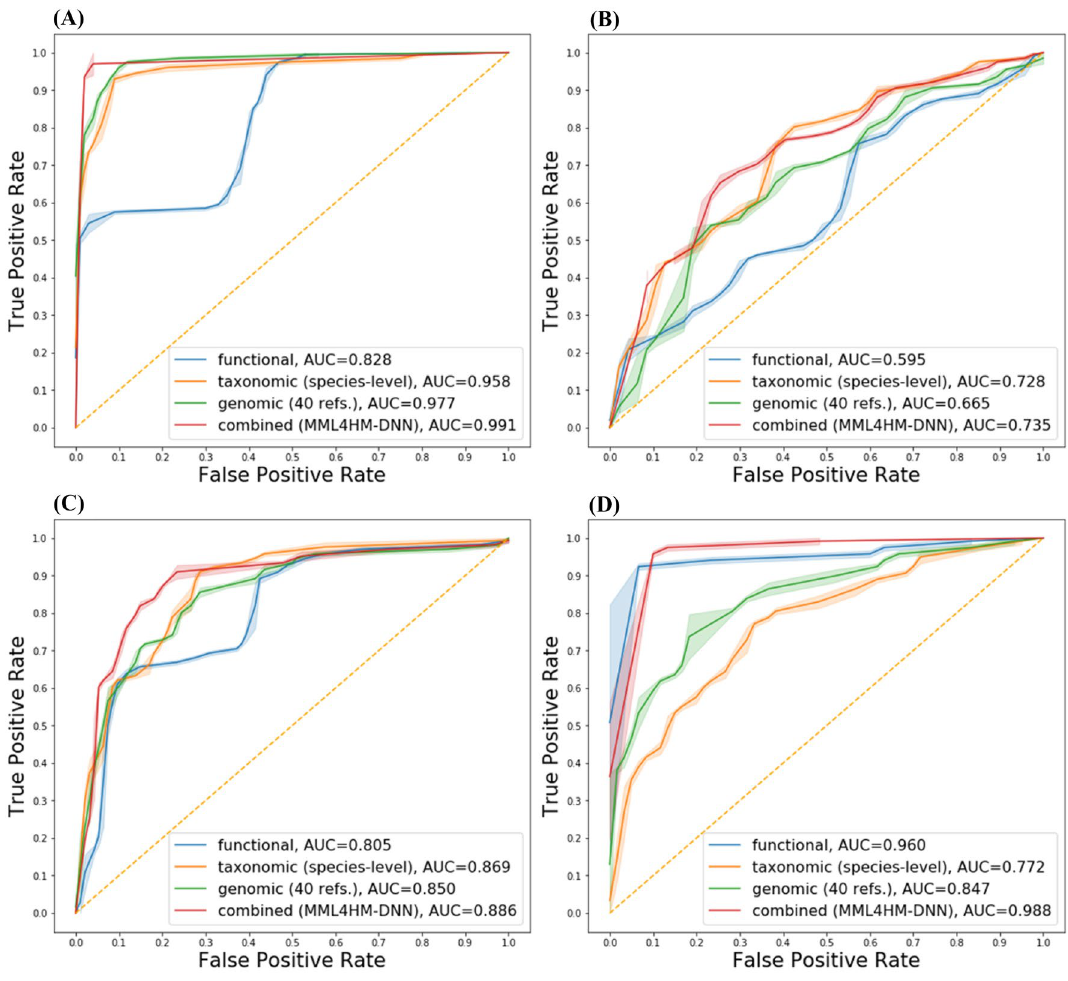
Figure 3. ROC curves and AUCs for MDL4Microbiome with each feature and all features combined. For ROC curves, thresholds were selected as the means between any two consecutive values observed in the data. ROC curves and AUCs for the (A) IBD, (B) T2D, (C) LC, and (D) CRC